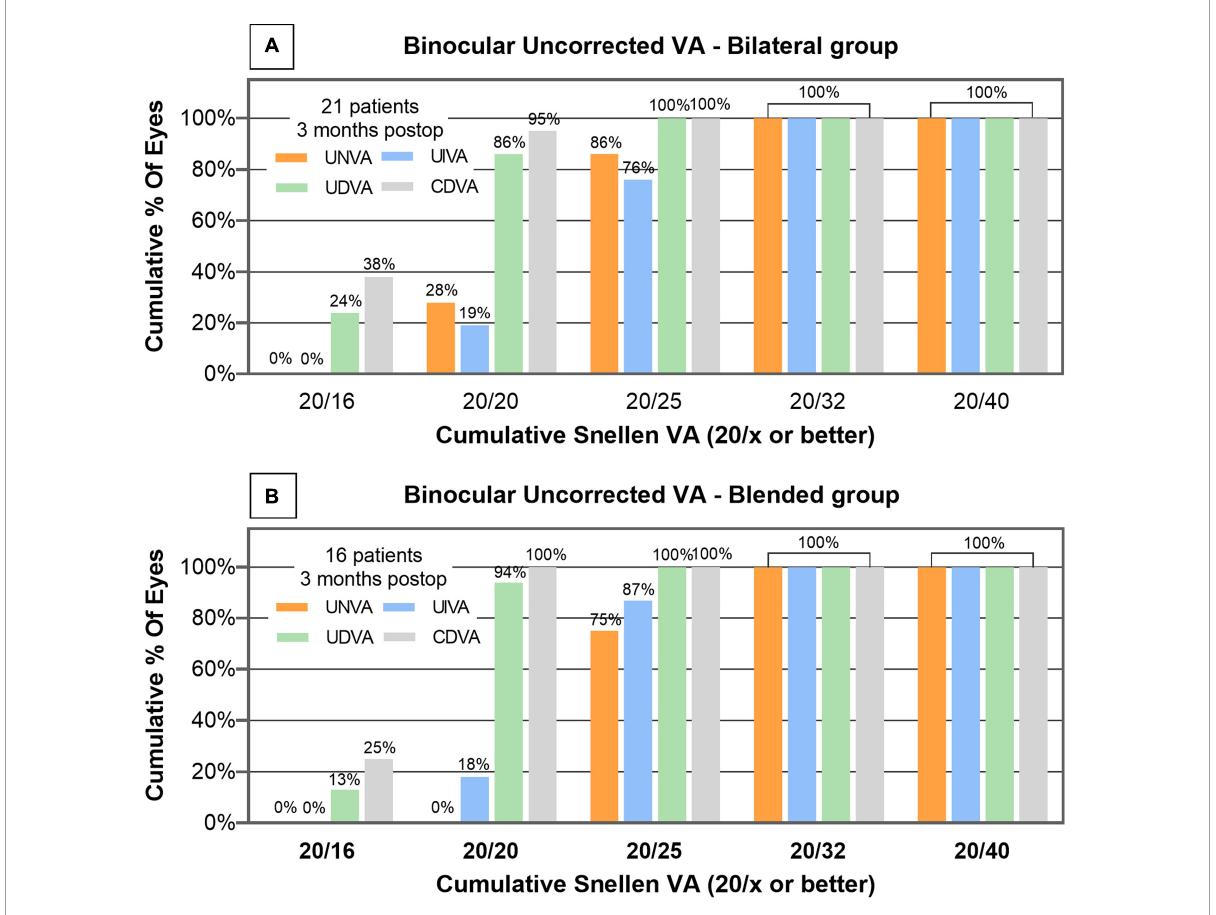
FIGURE3 Distribution of postoperative binocular UNVA, UIVA, UDVA and CDVA of bilateral group (A) and blended group (B) measured 3 months after cataract surgery. corrected distance visual acuity = CDVA; uncorrected distance visual acuity = UDVA; uncorrected intermediate visual acuity = UIVA; uncorrected near visual acuity = UNVA; VA = visual